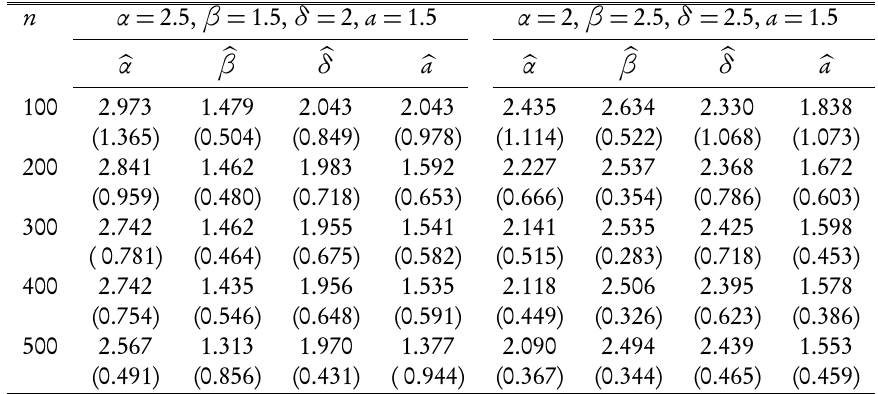
Empirical means and the RMSEs of the MOG-LL